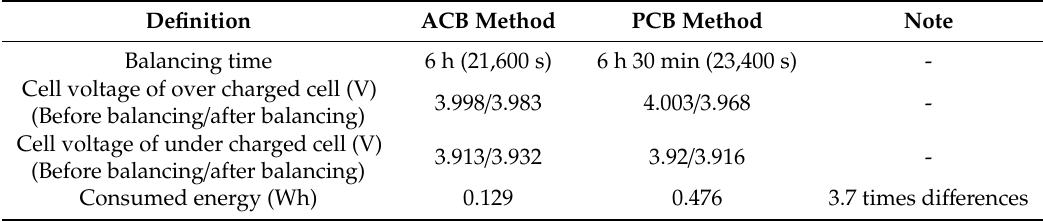
Figure 9. Experimental waveforms according to cell-balancing method: ( a ) the ACB method; ( b ) the PCB method. Table 10. Comparison between the ACB method and the PCB method by experimental results.